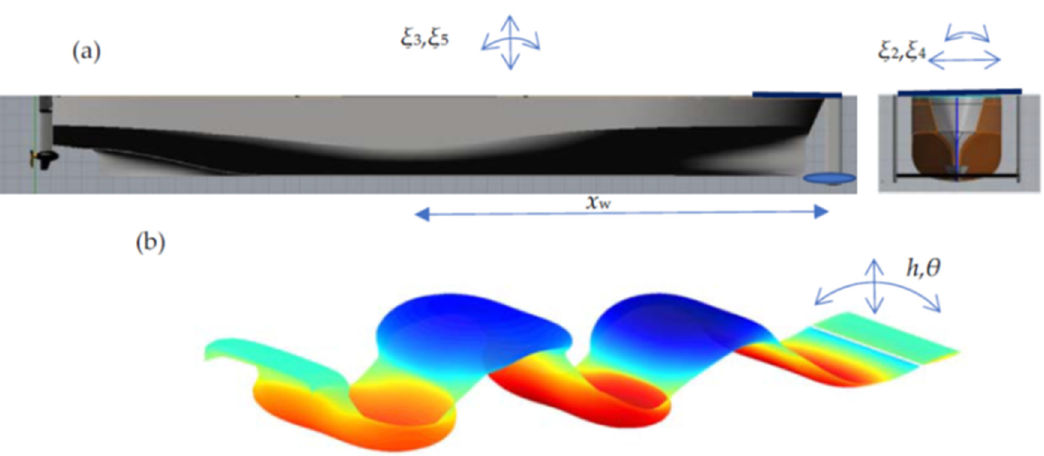
Figure 1. ( a ) Self-propelled ship with a dynamic wing arranged at the bow operating as a flapping thruster due to its vertical motion h (t) induced by the ship vertical ( ξ 3 , ξ 5 ) and transverse ( ξ 2 , ξ 4 ) responses in waves, in conjunction with ( b ) the controlled self-pitching foil motion θ ( t ).